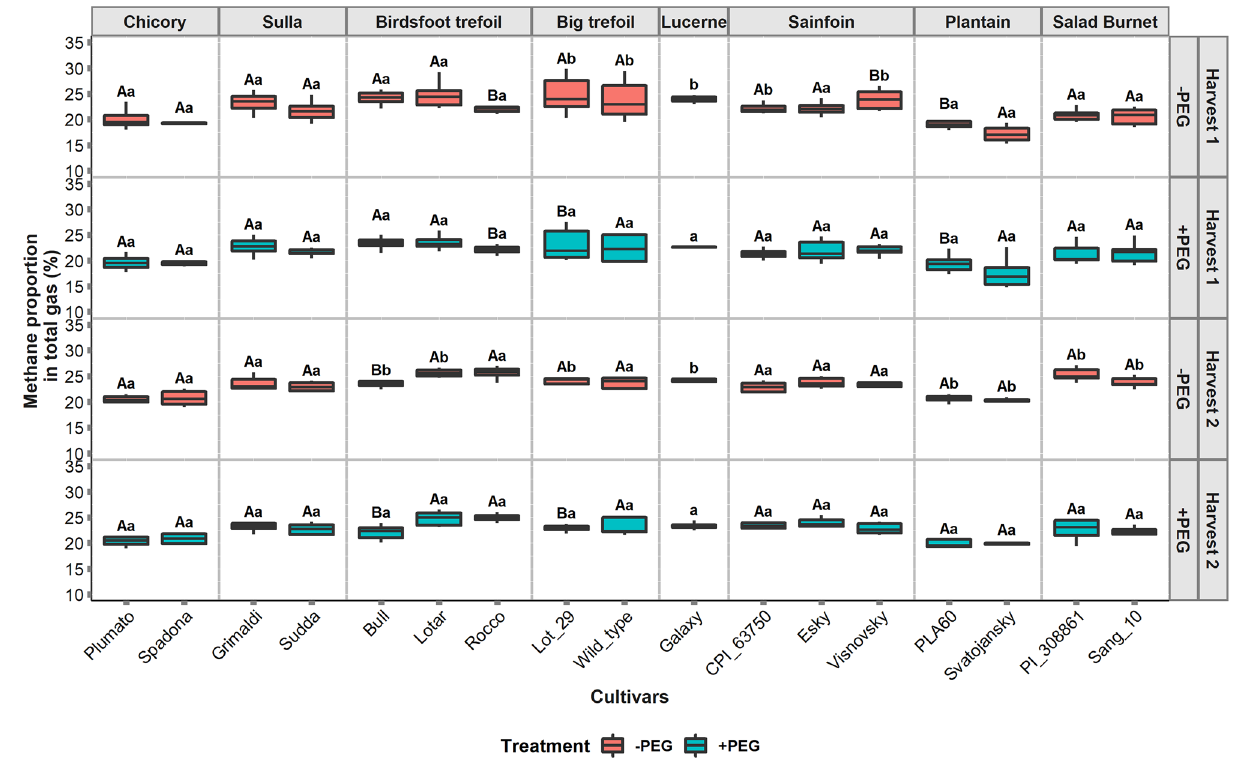
Figure 4. Methane percentage in total gas from 17 cultivars of 8 species under different treatments for two harvests. −PEG indicates the samples incubated without polyethylene glycol (PEG) and + PEG refers to the samples incubated with PEG. Different uppercase letters represent significant differences ( P < 0.05) between the cultivars for each species, and different lowercase letters represent the significant differences within the treatments for each cultivar.